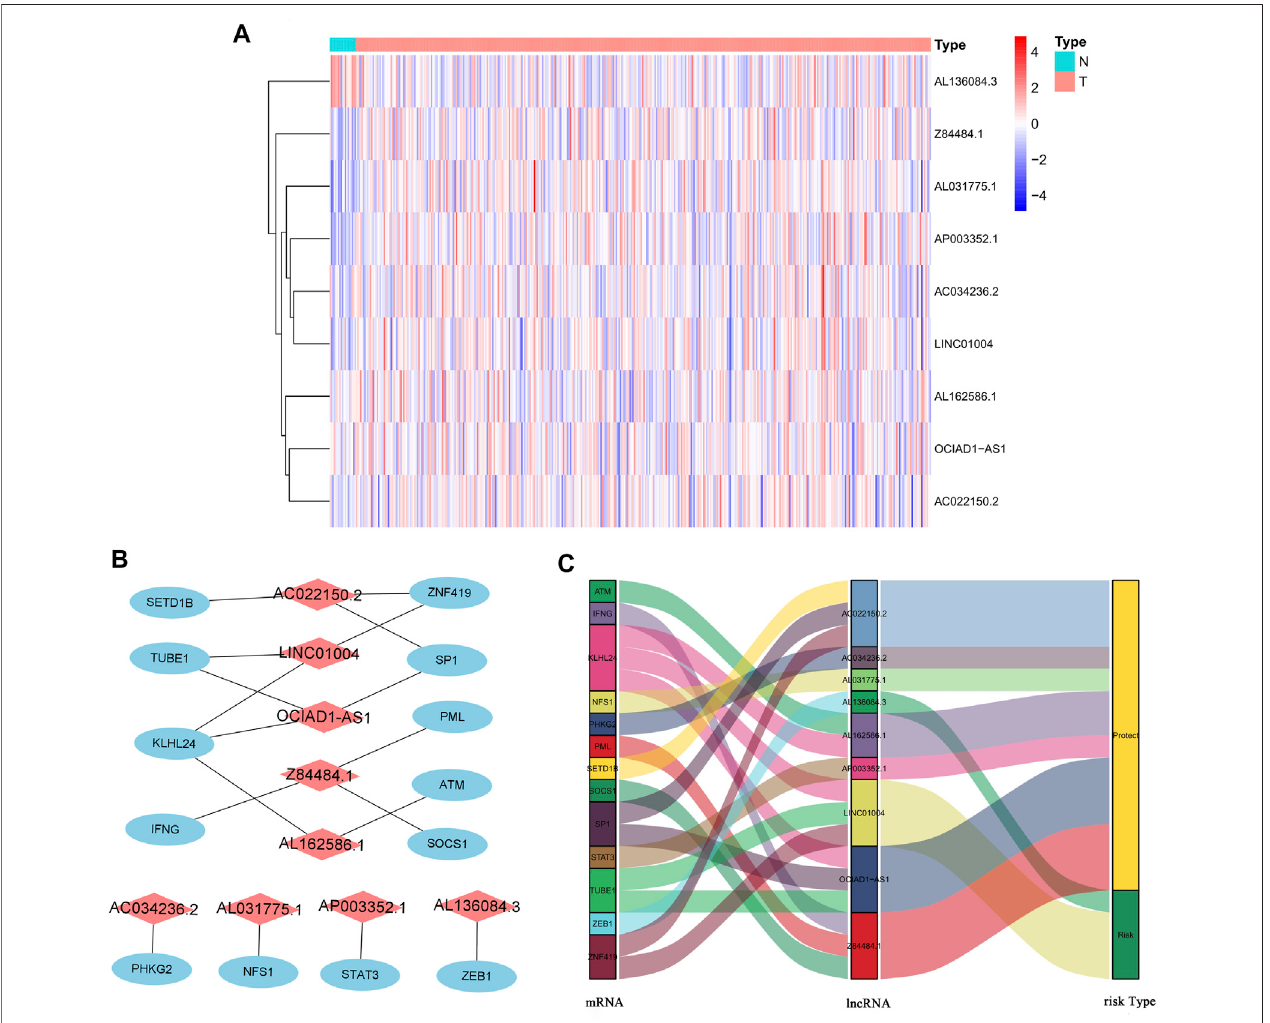
FIGURE 3 | The expression levels and lncRNA-mRNA network of nine ferroptosis-related lncRNAs in the predictive signature. (A) The expression levels of nine ferroptosis-related lncRNAs in BC and normal tissues. (B) The co-expression network of prognostic ferroptosis-related lncRNAs. (C) Sankey diagram of prognostic ferroptosis-based lncRNAs. lncRNAs, long noncoding RNAs; BC, bladder cancer; N, normal; T, tumor.